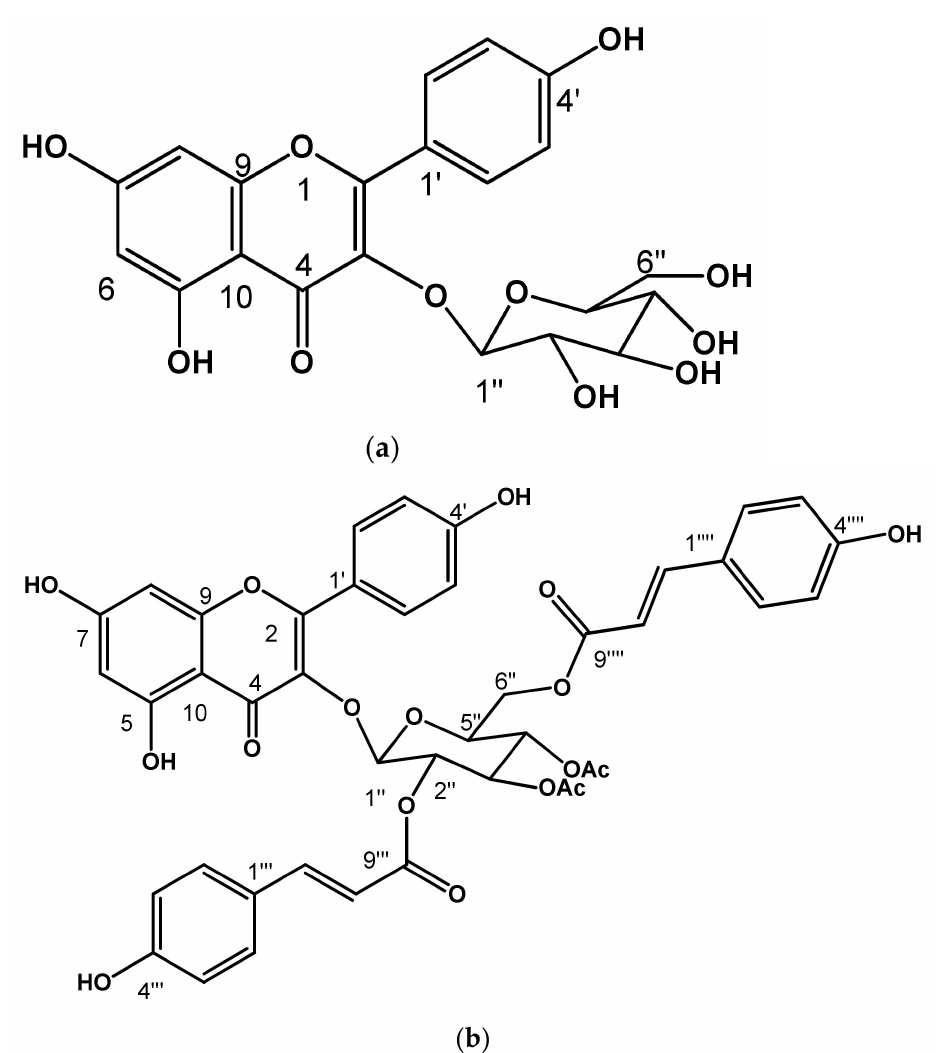
Figure 3. Chemical structure of identified flavonoids ( a ) Kaempferol − 3 − O − glucopyranoside, ( b ) Kaempferol − 3 − O − (3 (cid:48)(cid:48) ,4 (cid:48)(cid:48) − Diacetyl − 2 (cid:48)(cid:48) ,6 (cid:48)(cid:48) − di − E − p − coumaroyl) − glucopyranoside (see